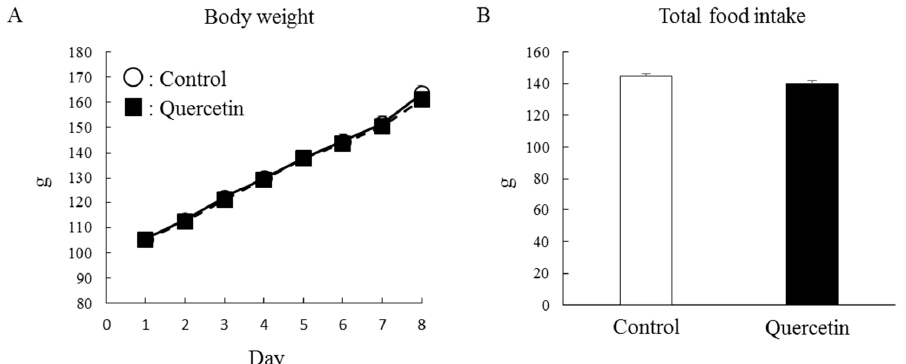
Figure 3. Effects of 7-day quercetin treatment on body weight and food intake. Rats were assigned to either a control or quercetin groups and were maintained under ad libitum feeding for 7 days. During this period, daily body weight ( A ) and total food intake ( B ) were measured. Values are means ± SE ( n = 13–14).